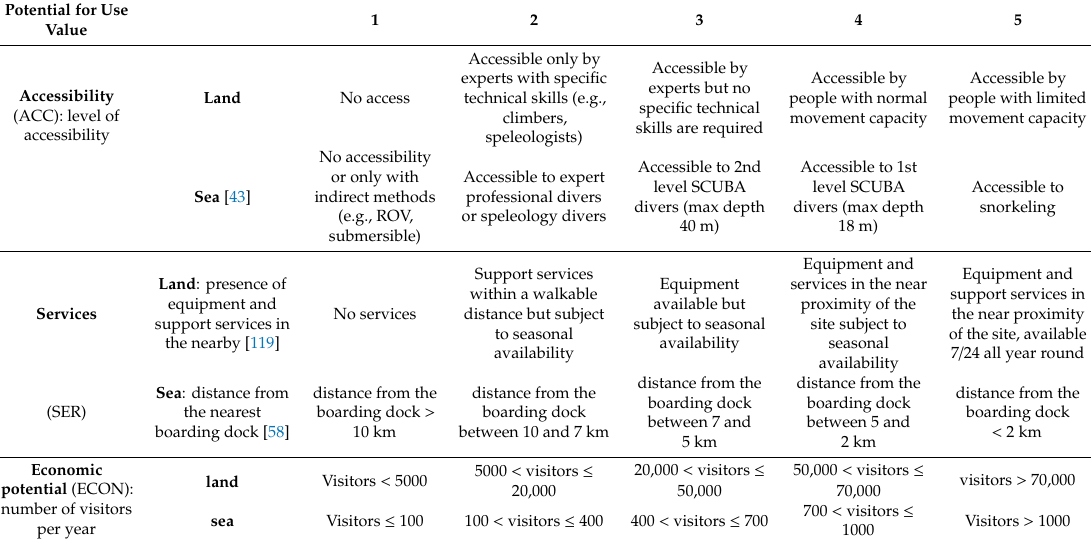
Table 5. Sub-criteria used for the numerical assessment of geosite potential for use.